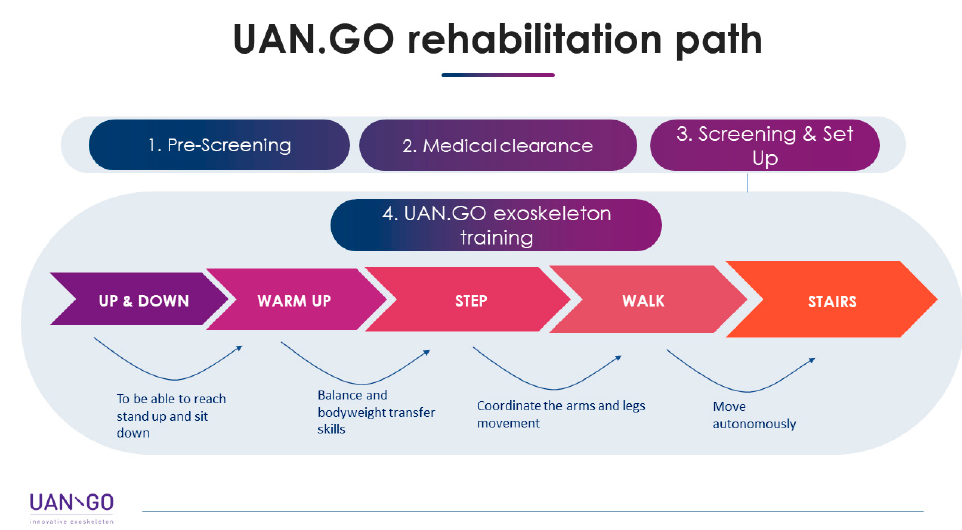
Figure 1. UAN.GO treatment protocol; developed by U&O.